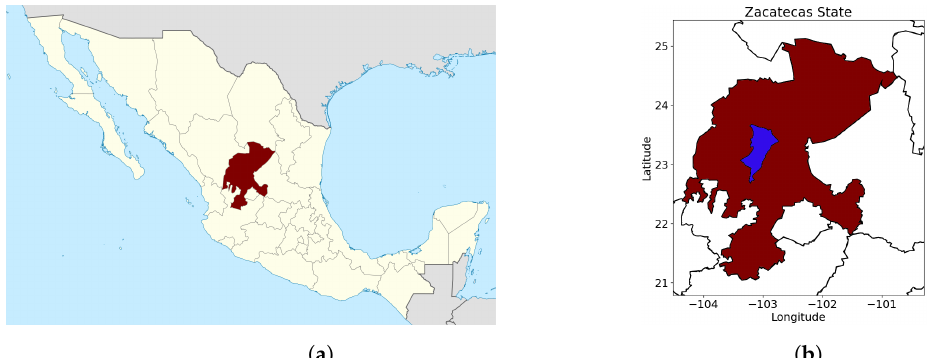
Figure 1. Location of Zacatecas State in Mexico ( a ) and the Aguanaval Aquifer polygon ( b ) for the